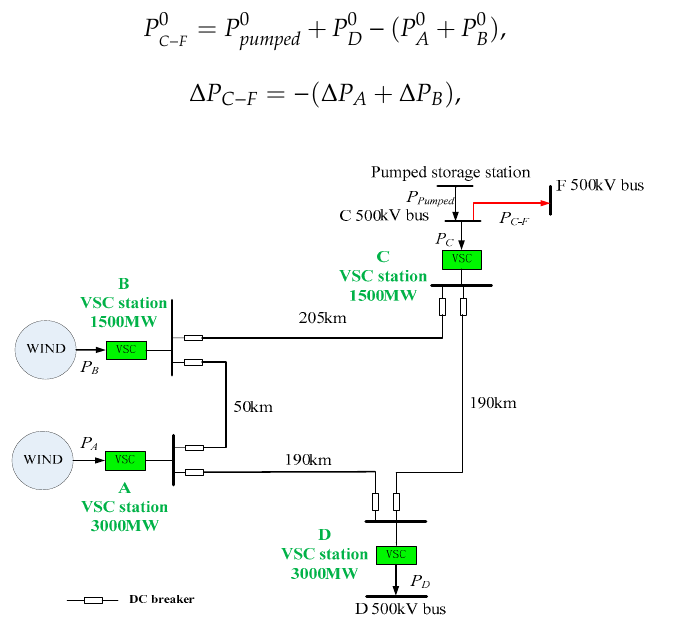
Figure 1. The multi-terminal direct-current (MTDC) grid configuration.